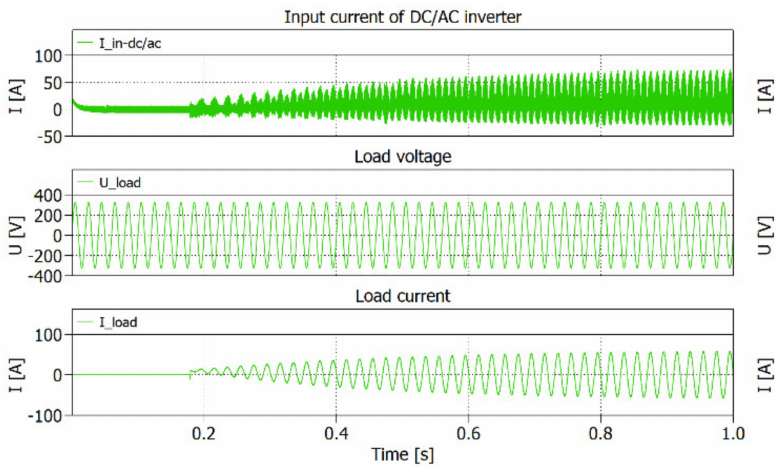
Figure 26. Current and voltage of the grid load for Scenario